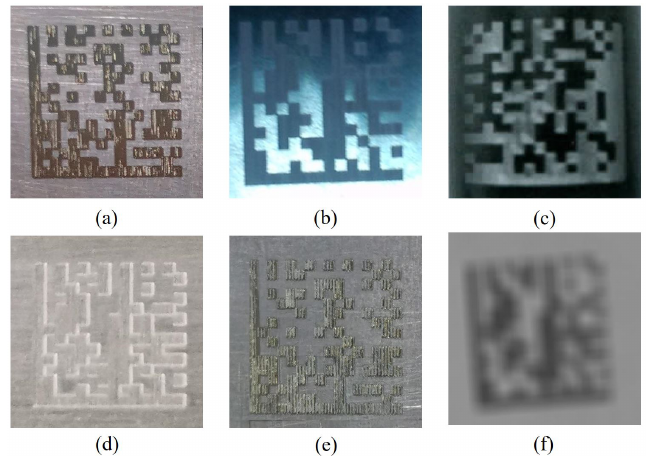
Figure 1. Some low-quality Data Matrix symbols: ( a ) exposure to aggressive environments; ( b ) un- even lighting; ( c ) curved surface; ( d ) low contrast; ( e ) rich texture; ( f )